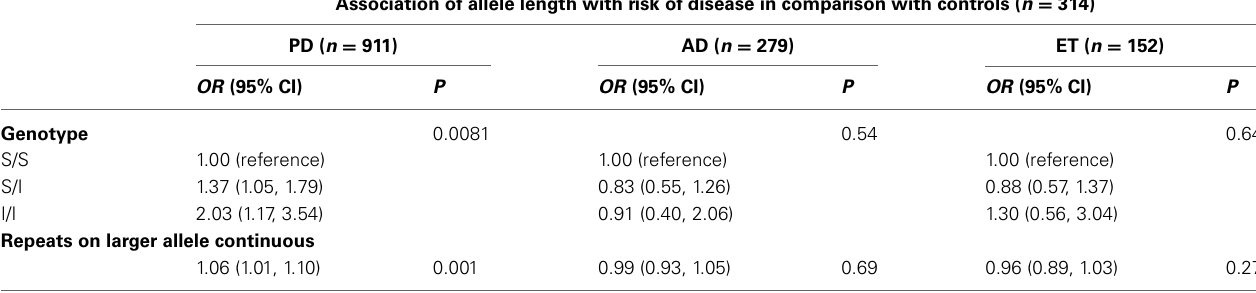
Table 4 | Association of allele length with risk of PD, AD, and ET diseases. Association of allele length with risk of disease in comparison with controls ( n =